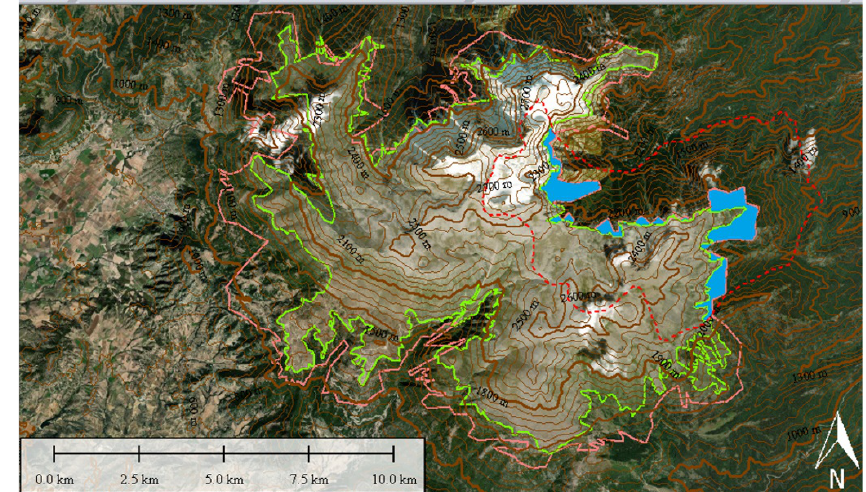
Figure 2. Area bare of vegetation in the year 1960 (vivid tangerine red line), and in the year 2020 (chartreuse green line) with contour lines per 100 m (reference: the year 2020). Area bare of vegetation (decrease) in the core of the National Park (sky-blue color).